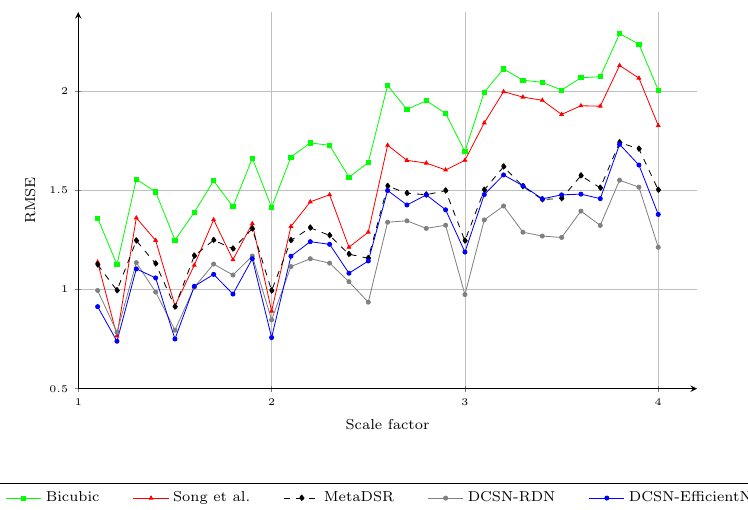
Figure 5. The RMSE of different upsampling factors [ 1.1,1.2,1.3,...,3.8,3.9,4.0 ] using different methods. We report the results of the modality in [40] trained with arbitrary scale factors, instead of that trained with specific scale factors. Note that the results for the method of Song et al., in noninteger cases, were obtained by applying bicubic interpolation to the upscaled results of the nearest integer scale factor.